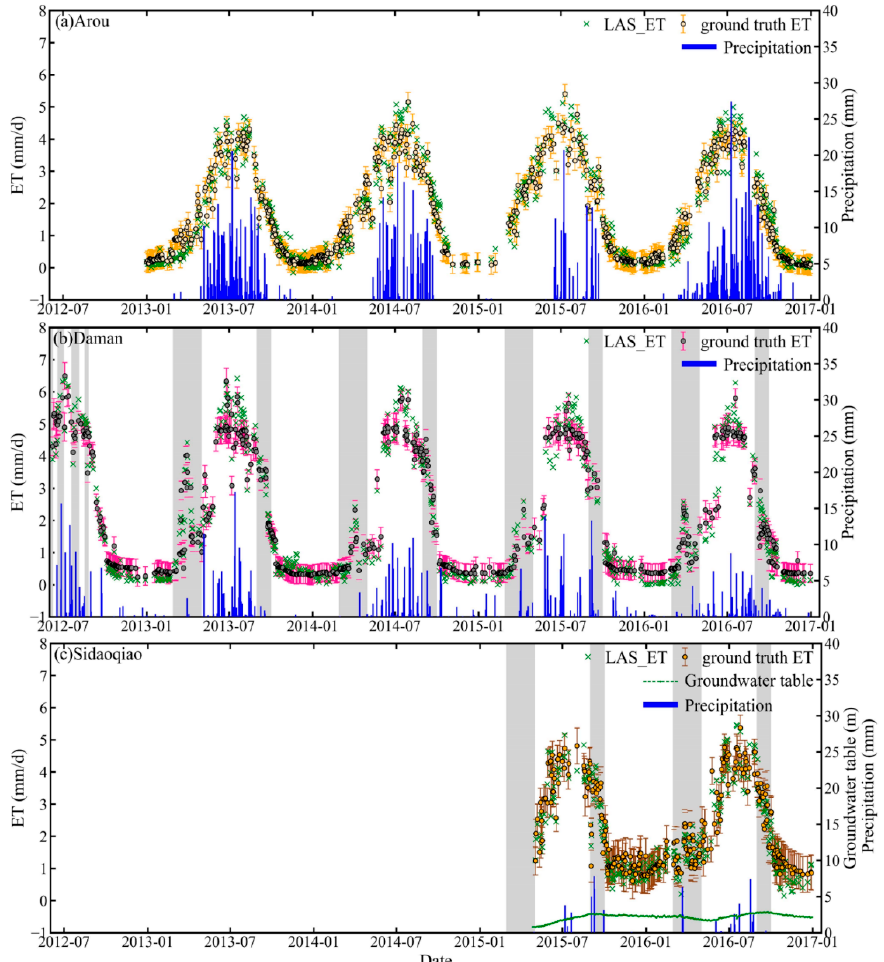
Figure 11. Daily ground truth ET at the satellite pixel scale (2 × 1 MODIS pixel) at the Arou ( a ), Daman ( b ), and Sidaoqiao ( c ) superstations (the error bar indicates the maximum and minimum value in the ground truth ET at the satellite pixel scale; the gray shadows represent irrigation peri- ods).